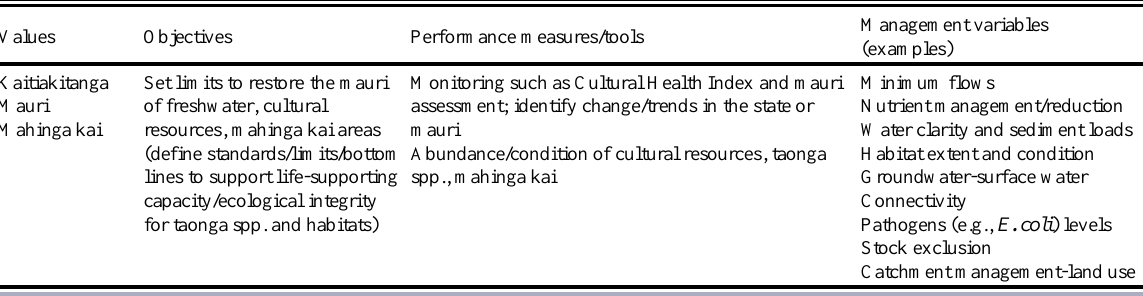
Table 2. Cultural monitoring to assess freshwater limits to maintain/enhance cultural values.